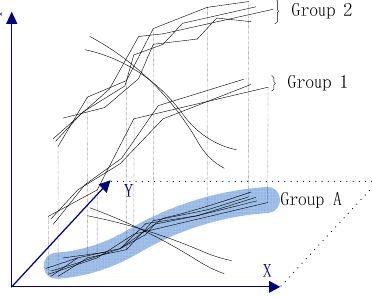
Fig. 4. Temporal feature of